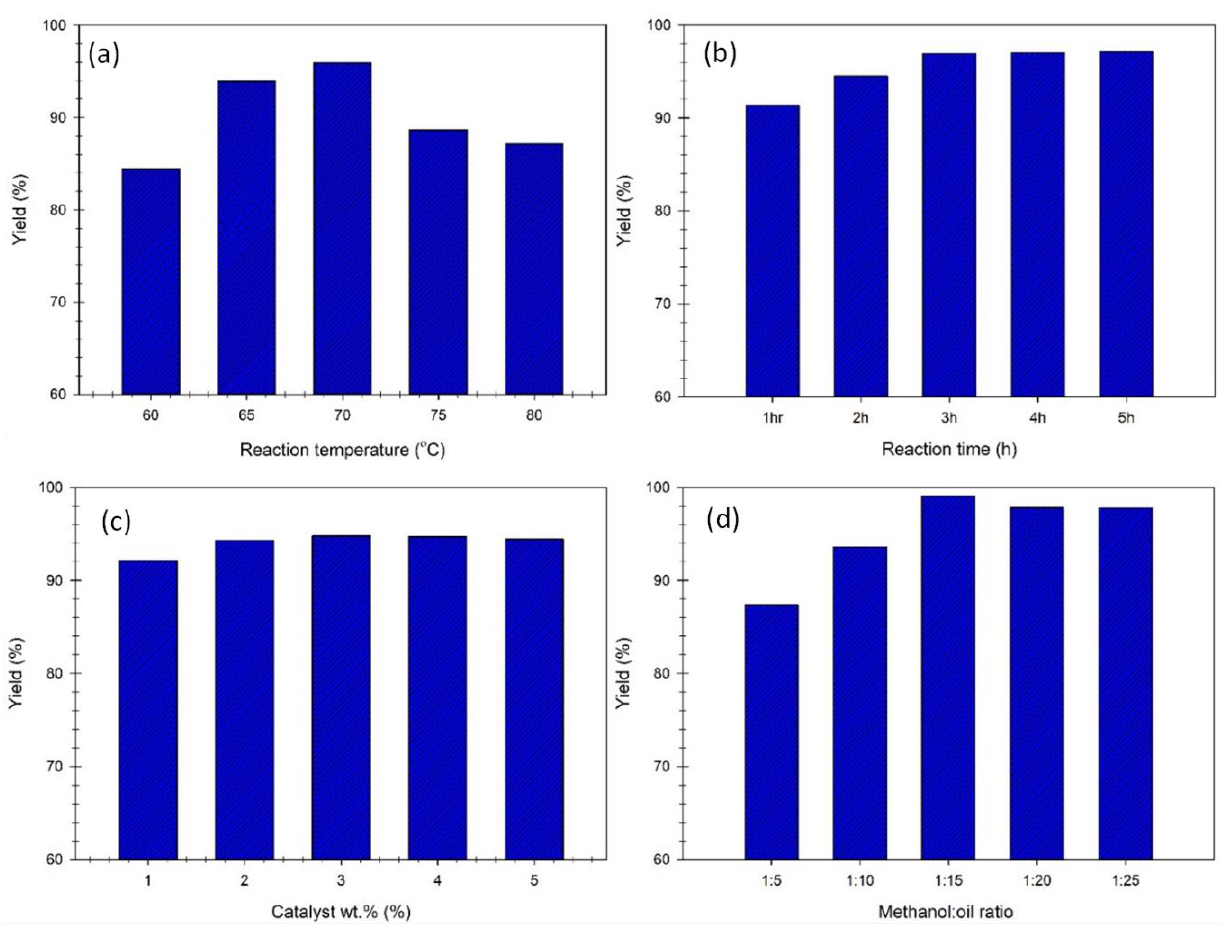
Figure 6. Optimization studies for biodiesel production over Cu 2 S (8%) -FeS (10%) /SiO 2 catalyst. ( a ) Effect of temperature on biodiesel conversion (methanol to PFAD molar ratio 15:1, catalyst concentration 3%, and 1 h reaction time). ( b ) Effect of reaction time on biodiesel conversion (methanol to PFAD molar ratio 5:1, catalyst concentration 3%, and reaction temperature 70 °C). ( c ) Effect of catalyst concentration on biodiesel conversion (methanol to PFAD molar ratio 5:1, temperature 70 °C, and 3 h reaction time). ( d ) Effect of methanol to PFAD ratio on biodiesel conversion (catalyst loading 2%, 3 h reaction time, and temperature 70 °C).